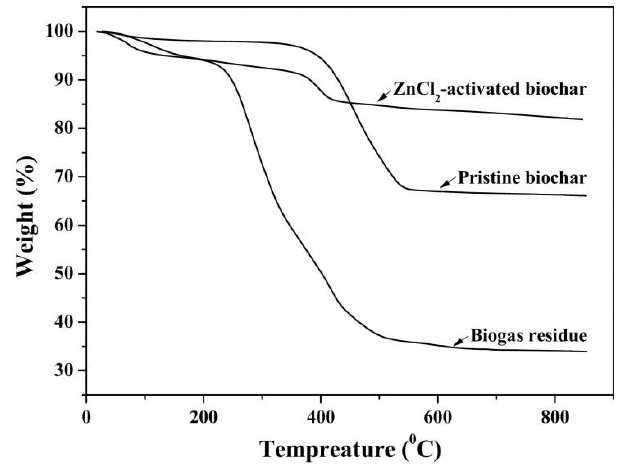
Figure 11. TG images of biogas residues, virgin biochar, and ZnCl 2 -impregnated biochar [108]. Reprinted with permission from DongXia et al. (2016). Copyright 2016, Elsevier.